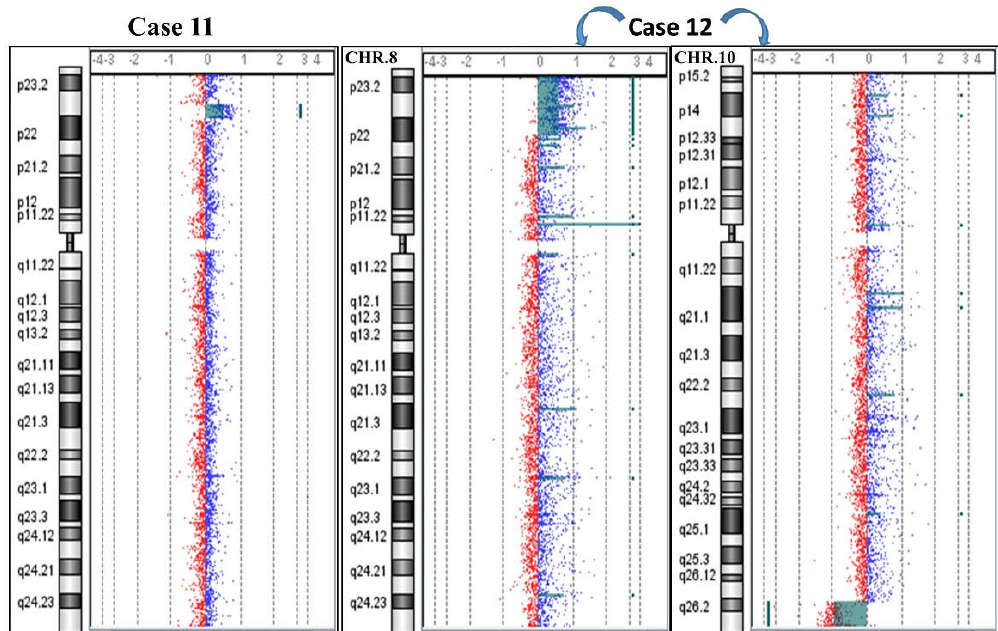
Figure 6. Cases 11 and 12. Array CGH results showing case 11 with a duplication ( left ) and case 12 with an 8p duplication and a 10q deletion due to an unbalanced maternal translocation t(8;10)(p22;q26.2) ( right ).